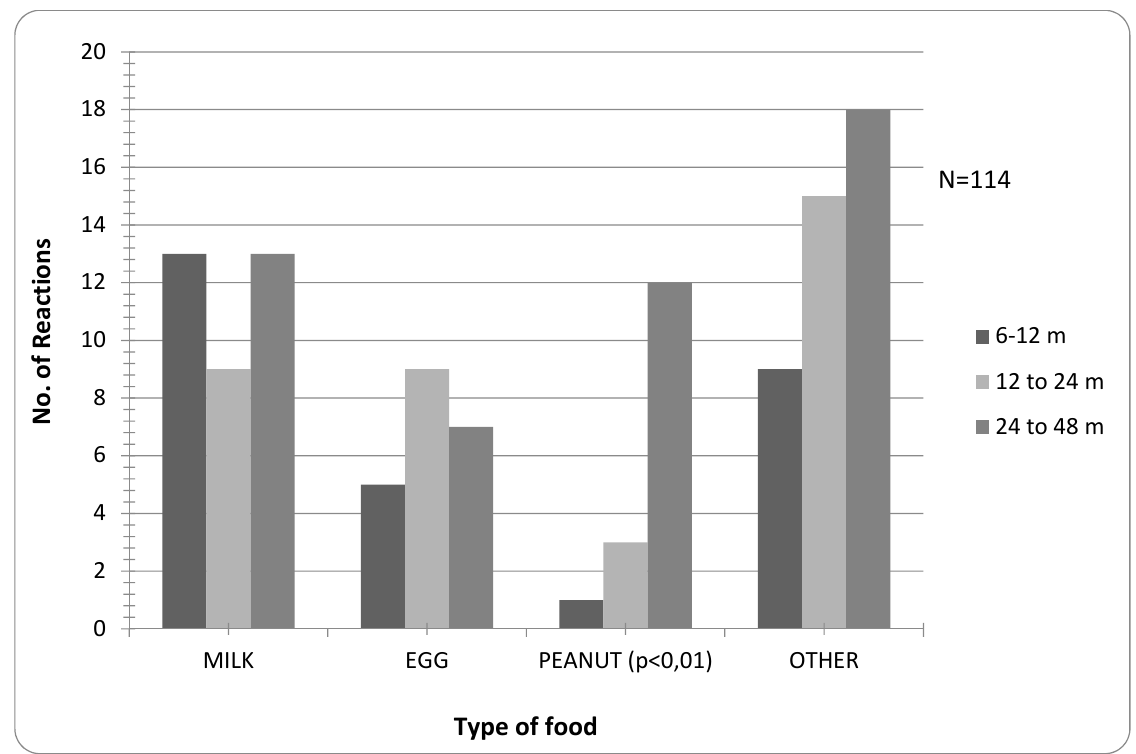
Figure 4. Frequency of suspected reactions to specific food according to age.